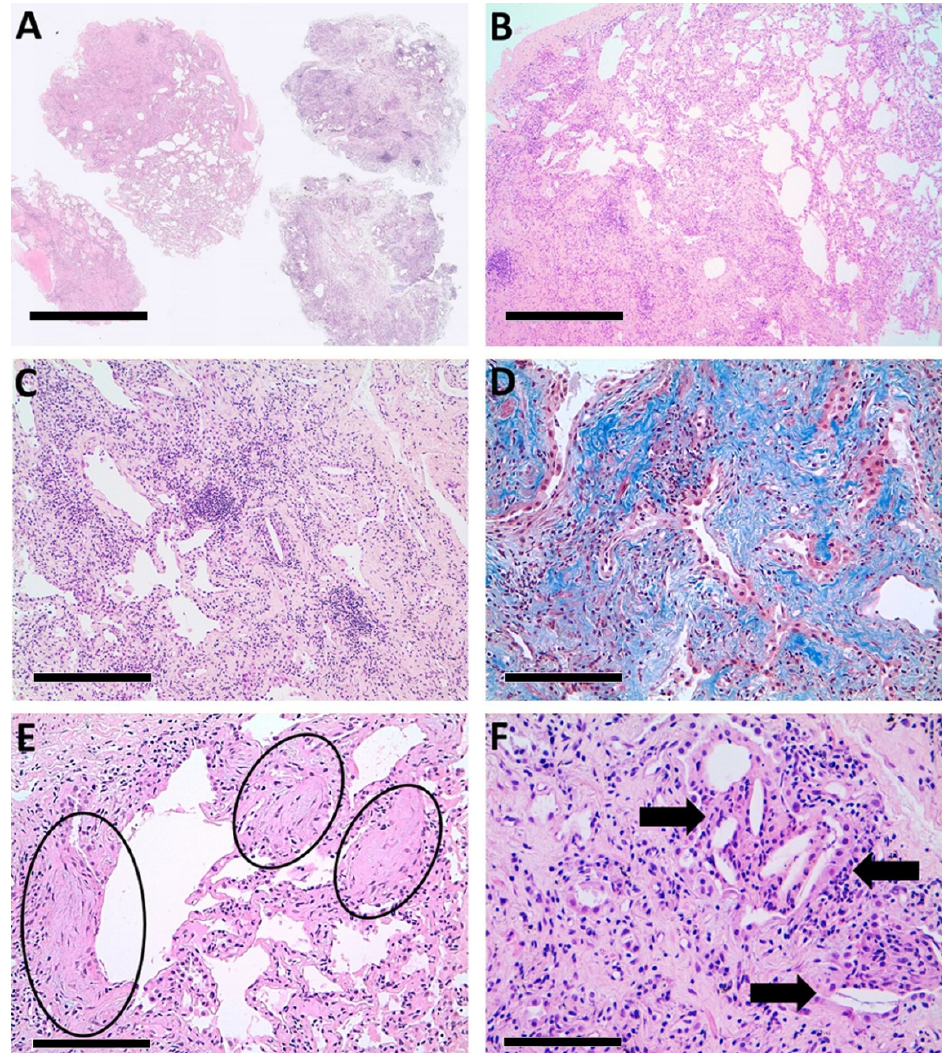
Figure 1. Most relevant histological lesions found in the patient’s biopsies. ( A ) The low-power image shows that the lesions affect all four cryobiopsies (H&E, ×2; scale bar = 150 μ m); ( B ) the parenchymal involvement is irregular (H&E, ×4; scale bar = 60 μ m); ( C ) diffuse interstitial fibrosis is accompanied by a partly nodular inflammatory infiltrate (H&E, ×10; scale bar = 25 μ m); ( D ) Mallory’s trichrome stain highlights (in blue) collagen fibrosis (×20; scale bar = 12.5 μ m); ( E ) the fibroblastic foci (circled) are numerous (H&E, ×20; scale bar = 12.5 μ m); ( F ) some cholesterin clefts (arrows) are surrounded by giant cells (H&E, ×40; scale bar = 6.25 μ m).